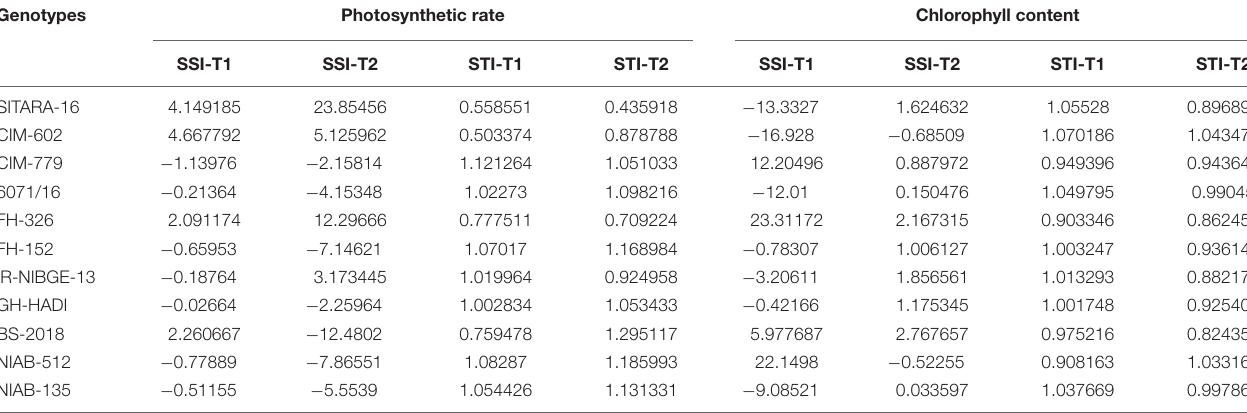
TABLE 7 | Stress susceptibility and tolerance indices for photosynthetic rate and chlorophyll content.